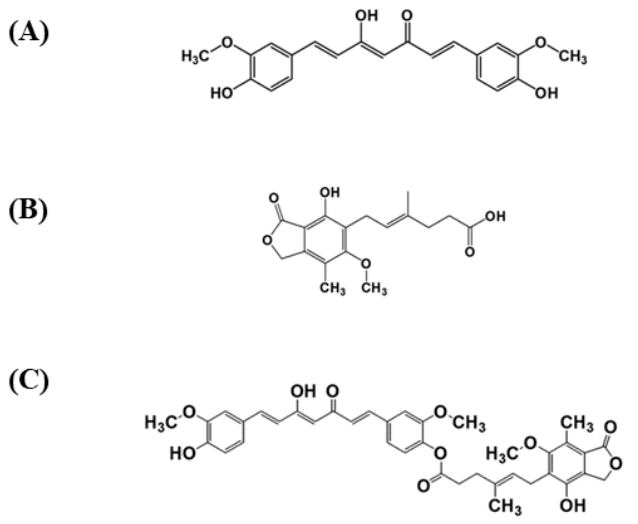
Figure 1. Chemical structures of ( A ) curcumin, CUR ( B ) mycophenolic acid, MPA, and ( C ) myco- phenolic acid-curcumin, MPA-CUR.